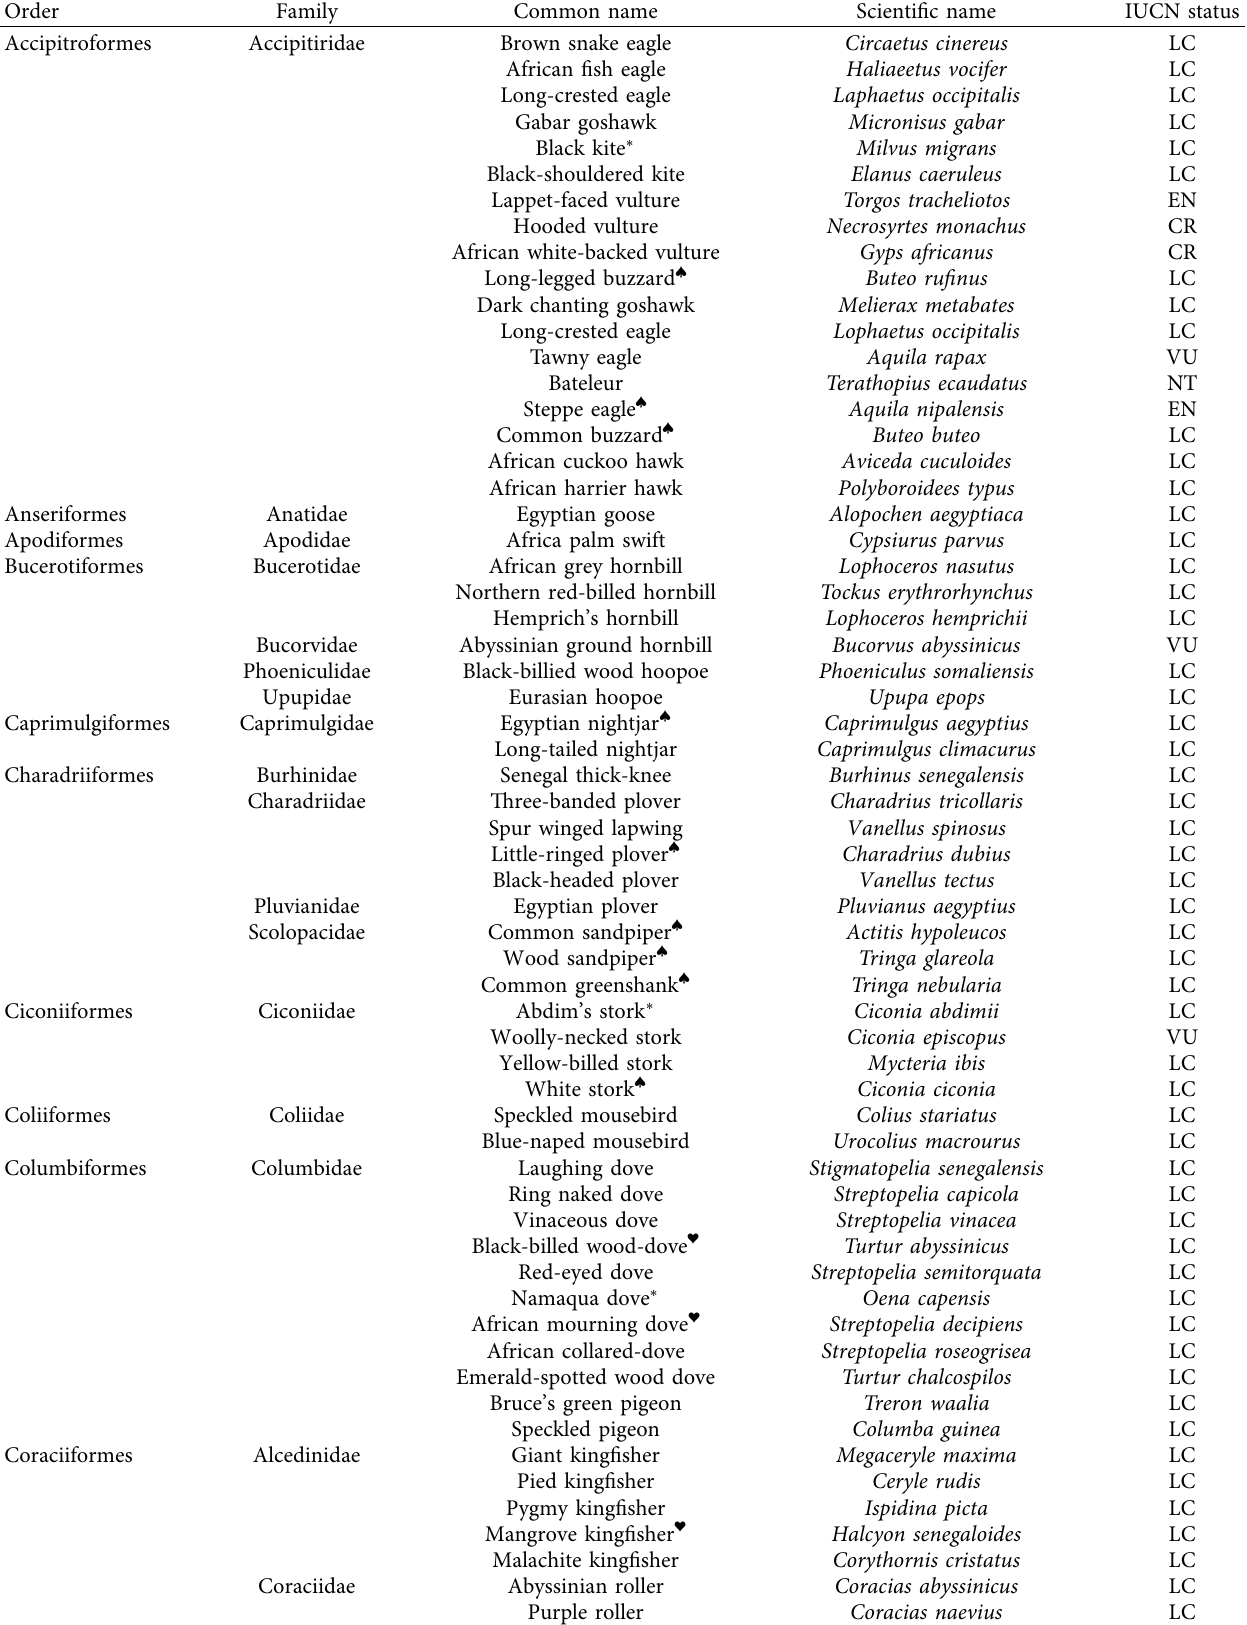
Table 1: List of bird species recorded in Kafta Sheraro National